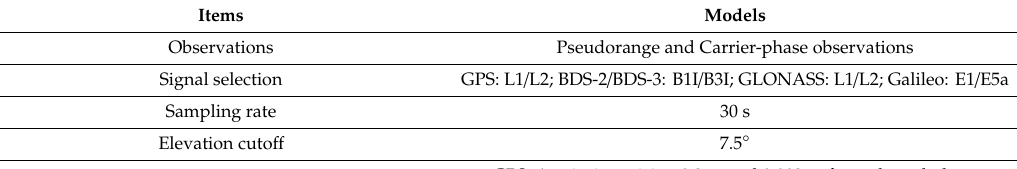
Table 1. Precise point positioning (PPP) processing